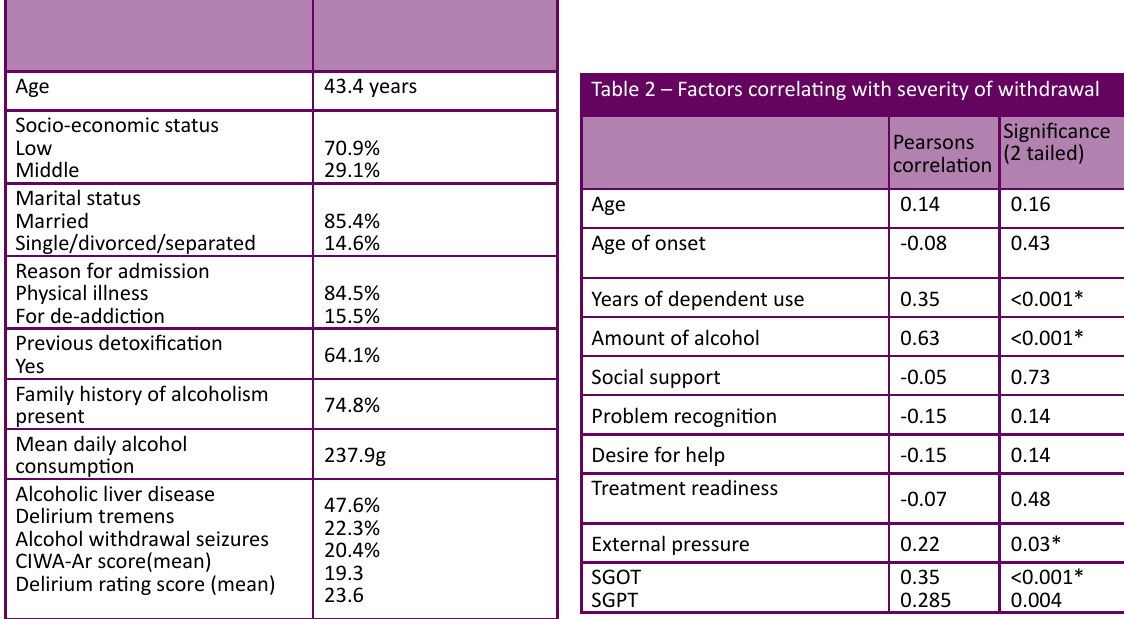
Table 2 – Factors correlating with severity of